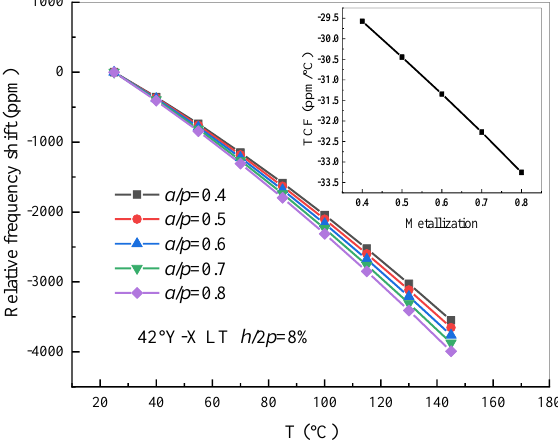
Figure 8. The relative frequency shift of 42° Y-X LT with different metallization ratios.